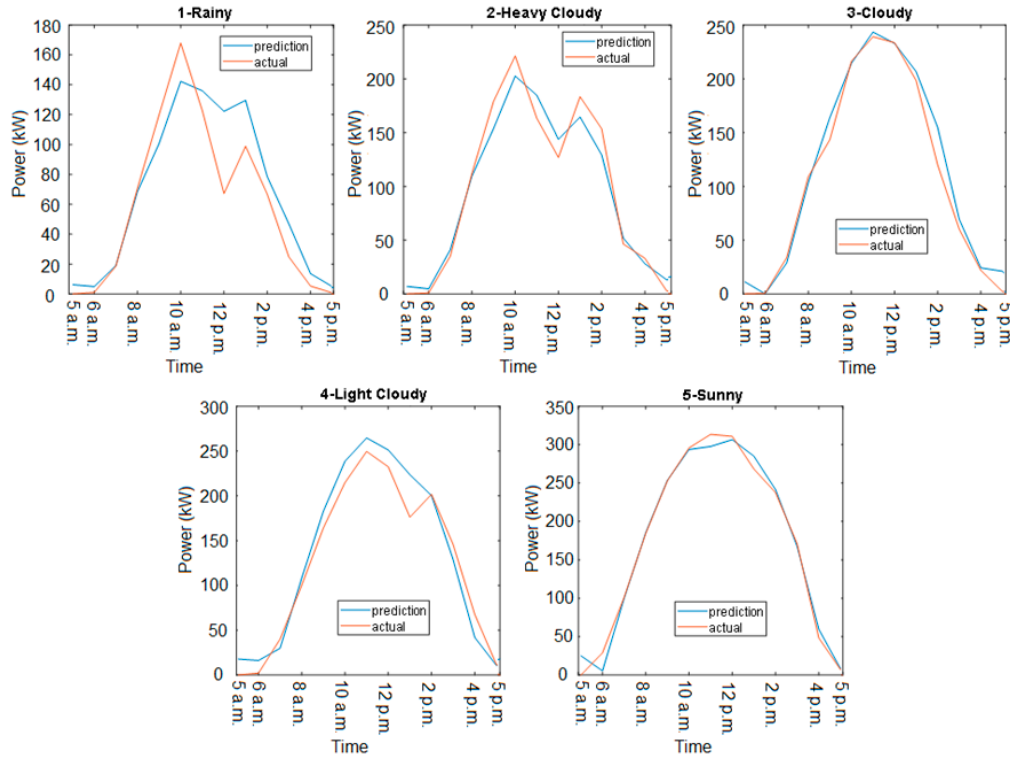
Energies 2020 , 13 , x FOR PEER REVIEW Figure 10. PV power forecasting result: one day ahead. Figure 10. PV power forecasting result: one day ahead.